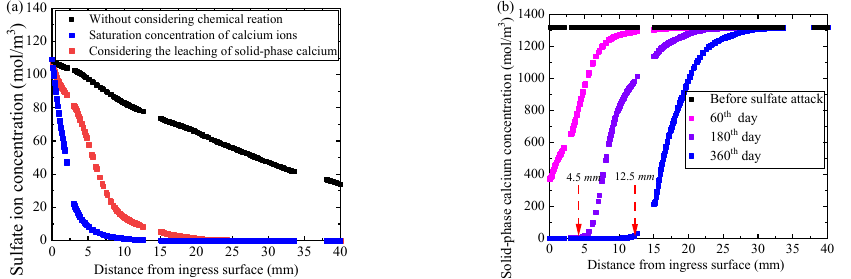
Figure 13. ( a ) Concentration distributions of sulfate ion in the concrete pore solution, and ( b ) concentration distribution of solid-phase calcium ion in the concrete on the 180th day of sulfate attack.